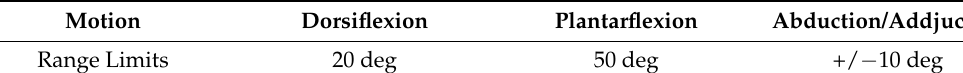
Table 1. Ranges of motion of the human ankle joint [1–3].